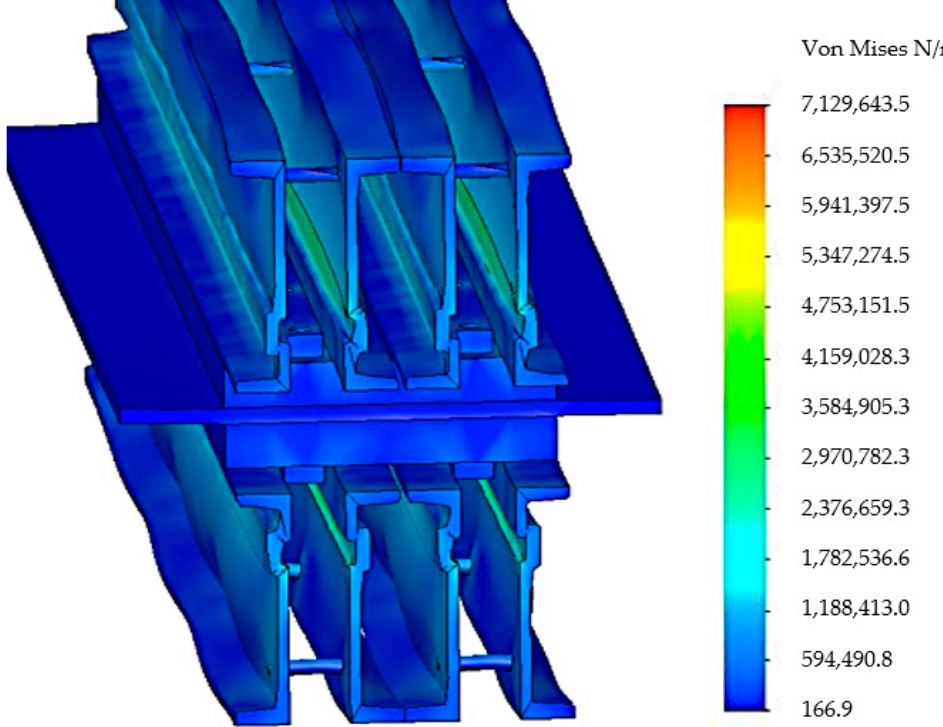
Figure 7. Distribution von Mises stress in the belt vulcanization press when using four spacers.